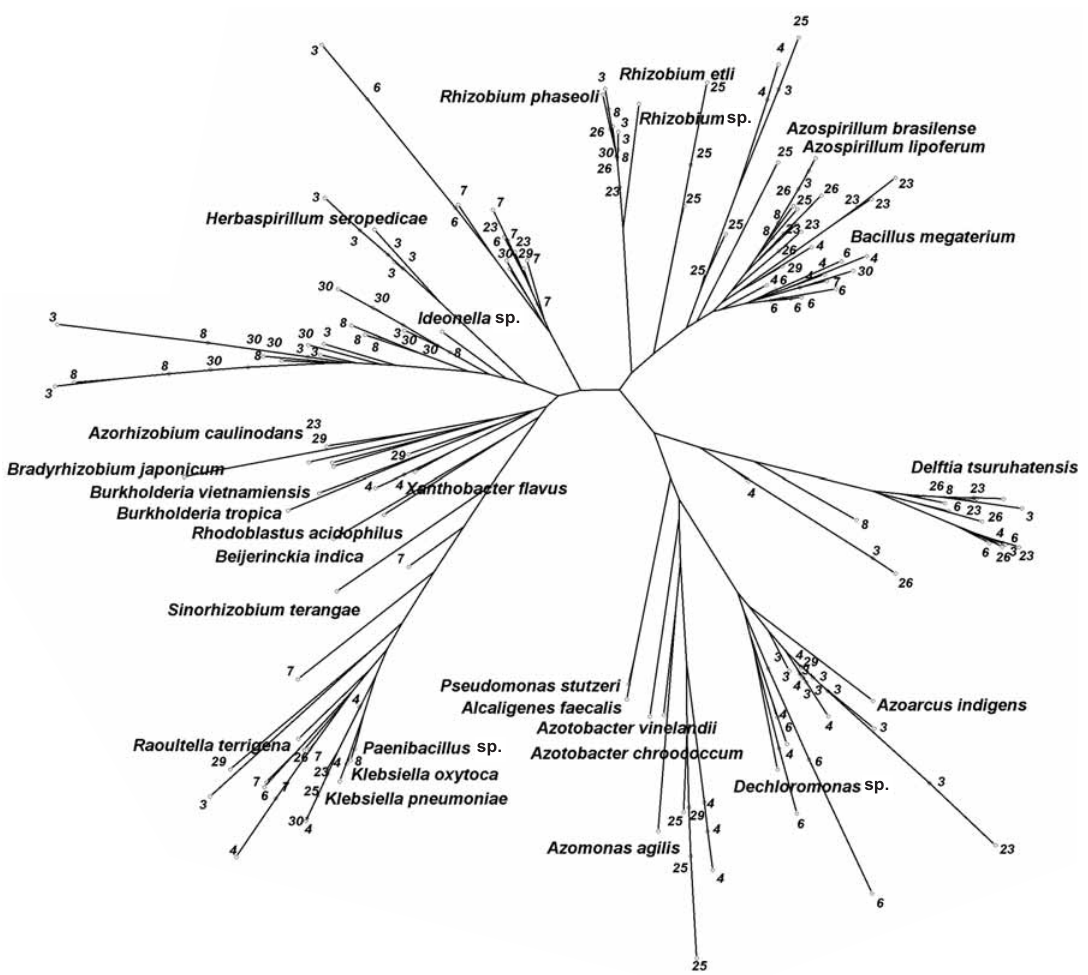
Figura 5. Árvore filogenética das seqüências representativas do gene nifH amplificadas a partir do DNA de bactérias endofíticas extraído do colmo de plantas de milho cultivado em diferentes regiões climáticas do Rio Grande do Sul e seqüências de referência do gene nifH de bactérias cultivadas removidas do banco de genes Genbank. Filogenia inferida usando o algoritmo do vizinho mais próximo. Árvore con- senso gerada pelo programa Splits Tree 4 (Huson & Bryant, 2006). Os algarismos arábicos representam o local de amostragem das plantas de milho. A escala representa o número de mutações por posição dos